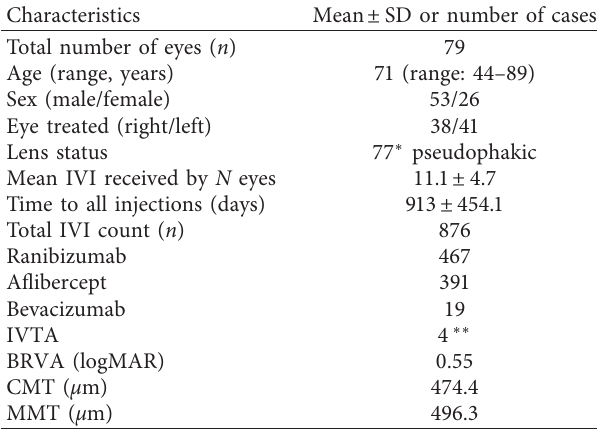
Table 1: Baseline demographics and ocular characteristics.